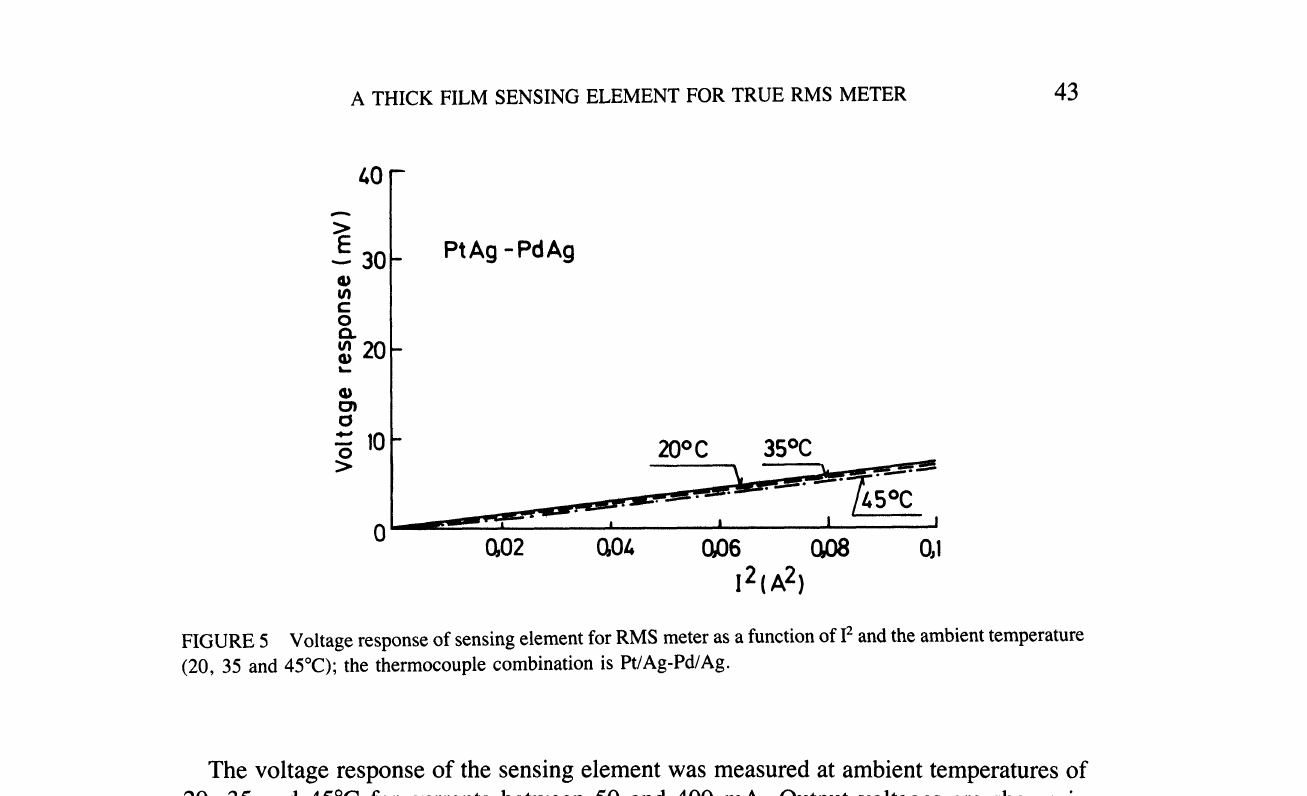
FIGURE 5 Voltage response of sensing element for RMS meter as a function of 12 and the ambient temperature (20, 35 and 45C); the thermocouple combination is Pt/Ag-Pd/Ag.